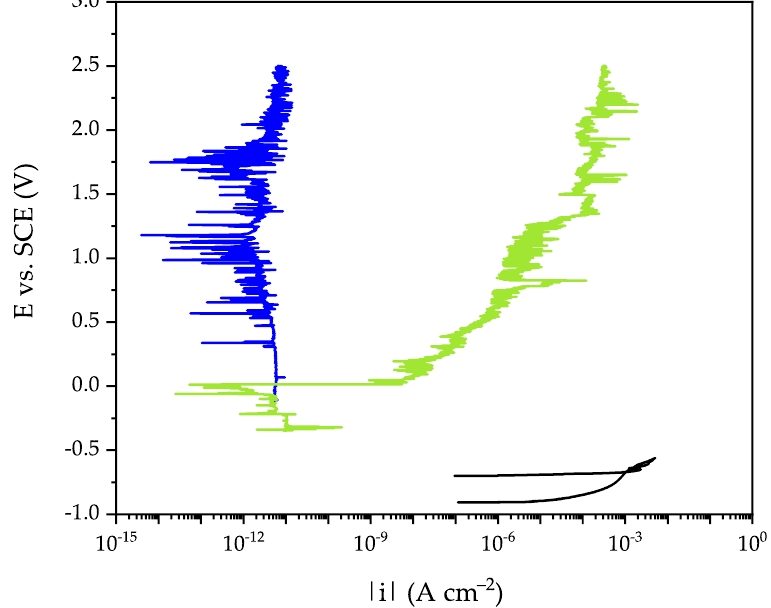
Figure 1. Representative potentiodynamic anodic polarization curves obtained for naked AA2024 (black; cyclic polarization) and for AA2024 coated by co-PPM 4.6% (green) and co-PPM 9.0% (blue) in naturally aerated 3.5% w/v NaCl solution. Potential scan rate: 10 mV/min.